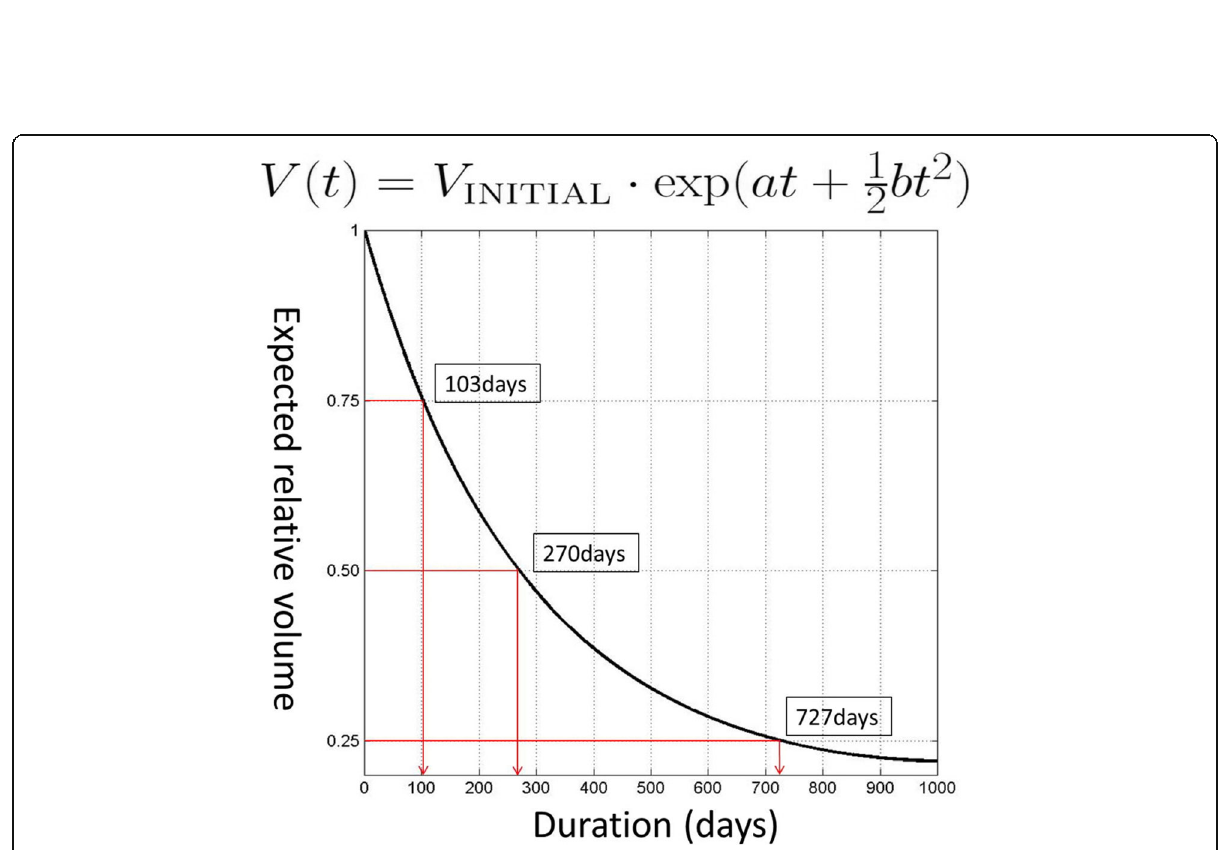
Fig. 3 The expected relative